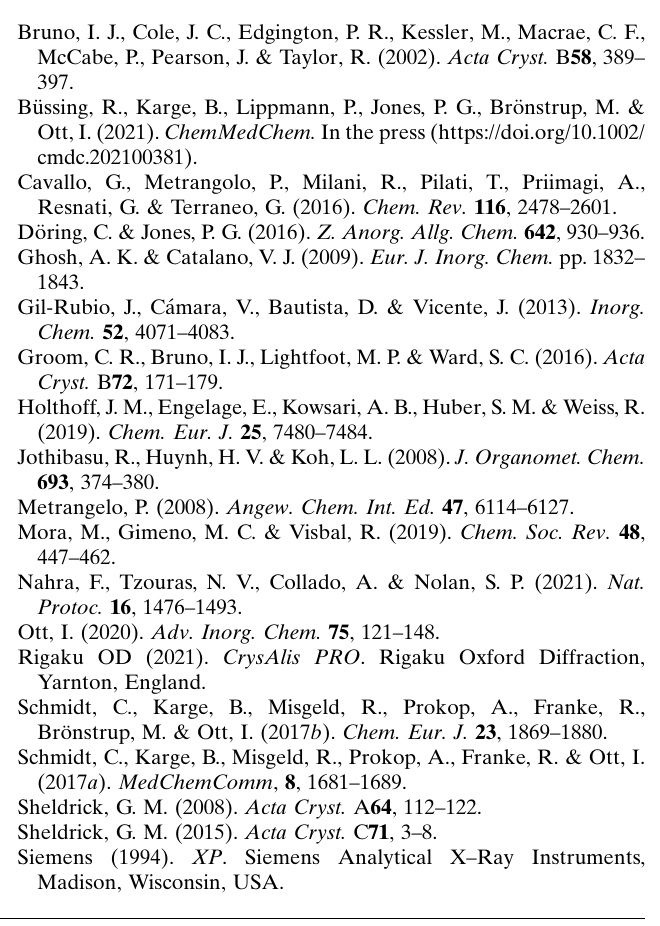
Crystal data Chemical